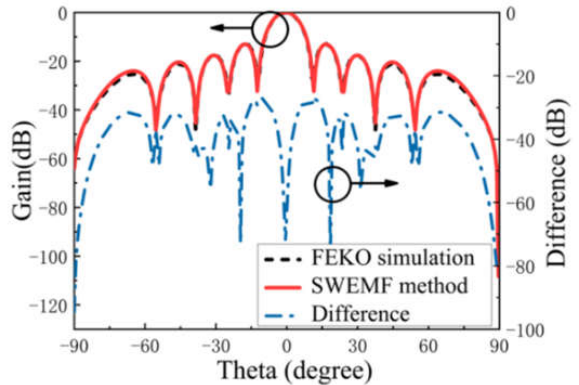
Figure 4. Comparison of the pattern of the FEKO-simulated dipole linear array and the pattern obtained by the SWEMF method.